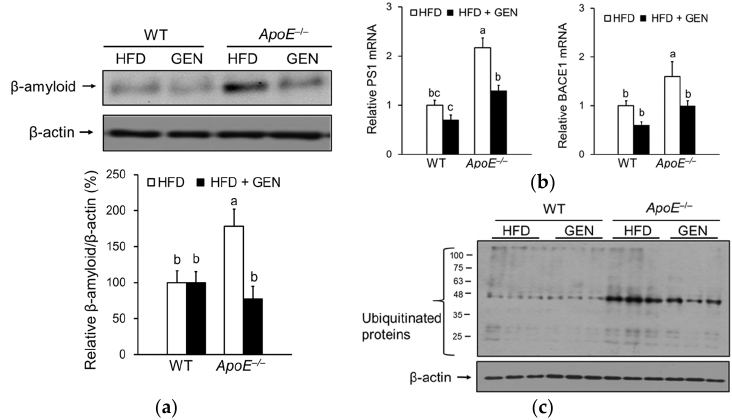
Figure 5. Effects of genistein on beta ‐ amyloid peptide (A β ) deposition in the cortex and hippocampus of WT and ApoE − / − mice fed an HFD. ( a ) Relative protein levels of A β were analyzed by immunoblotting and were normalized to beta ‐ actin ( n = 3); ( b ) relative mRNA expressions of genes involved in amyloid precursor protein (APP) processing, BACE1 and PS1, were analyzed by real ‐ time PCR and normalized to RPL19 ( n = 4–5); ( c ) ubiquitinated protein levels were analyzed by immunoblotting and were normalized to beta ‐ actin ( n = 3). Each bar represents the mean ± SEM and bars with different superscripts are significantly different at p < 0.05.